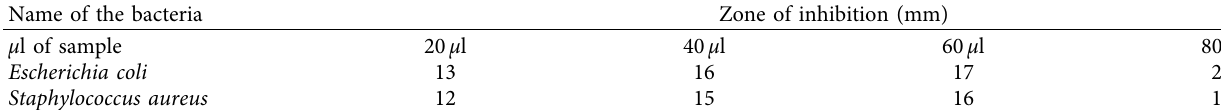
Figure 7: Antibacterial activity of the PEDOT-HNT/CS-MHA bilayer composite coating against (a) E. coli and (b) S. aureus bacteria. Table 1: Antibacterial activity